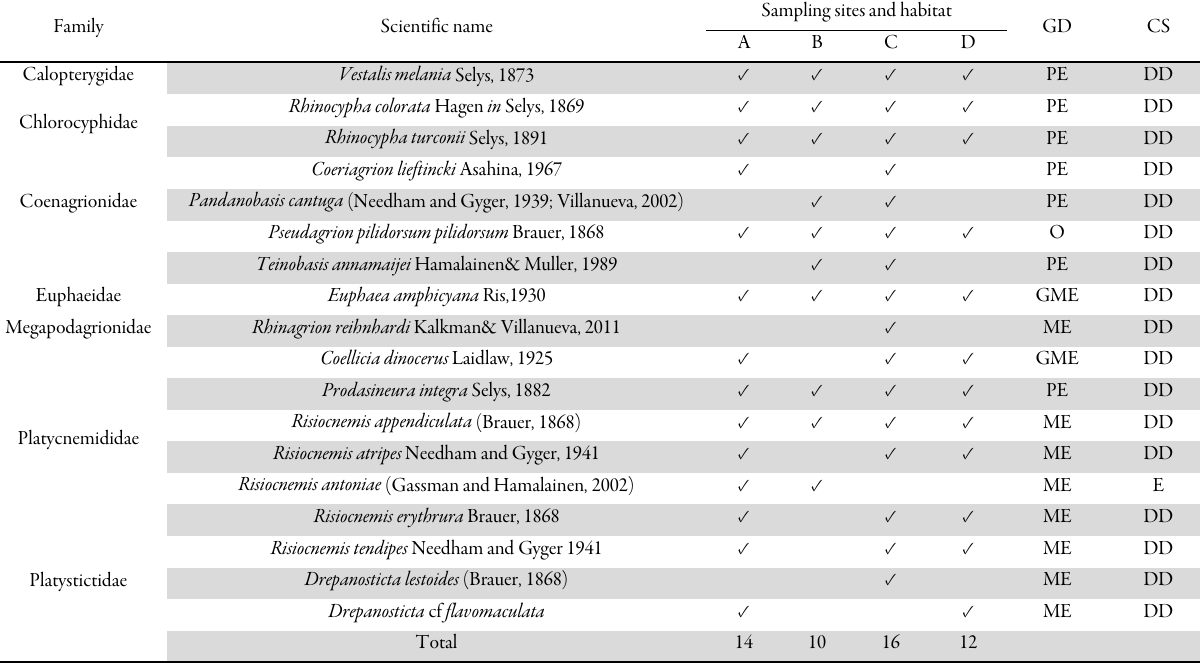
Table 1.Zygopterans recorded in MHRWS, Davao Oriental